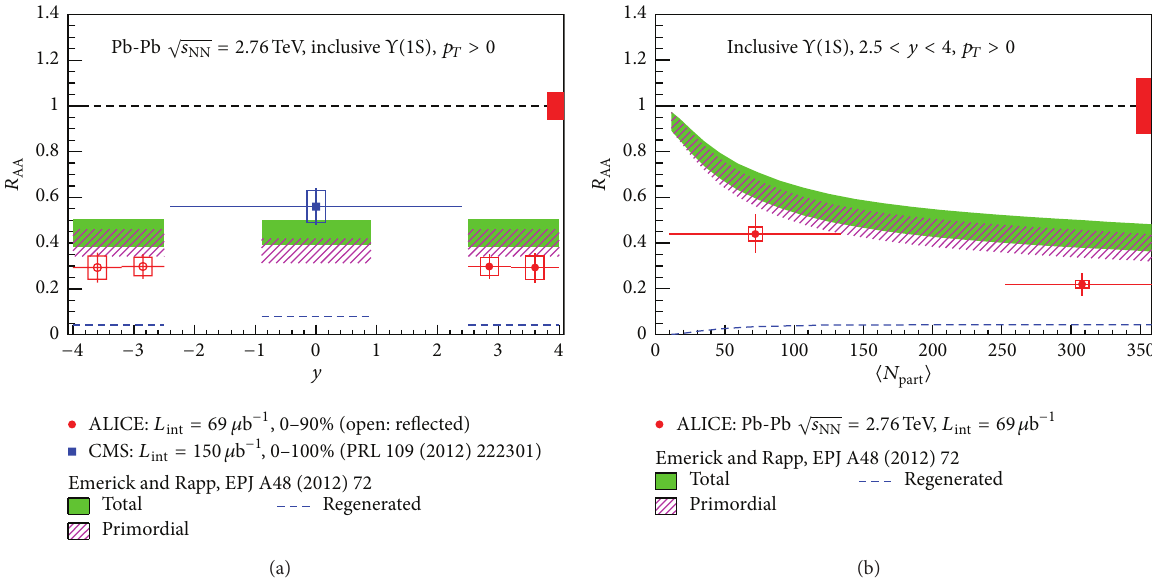
Figure 6: Comparison with theoretical predictions ALICE and CMS 𝑅 PbPb results for Υ (1S) versus rapidity (a) and ALICE results versus 𝑁 part (b).